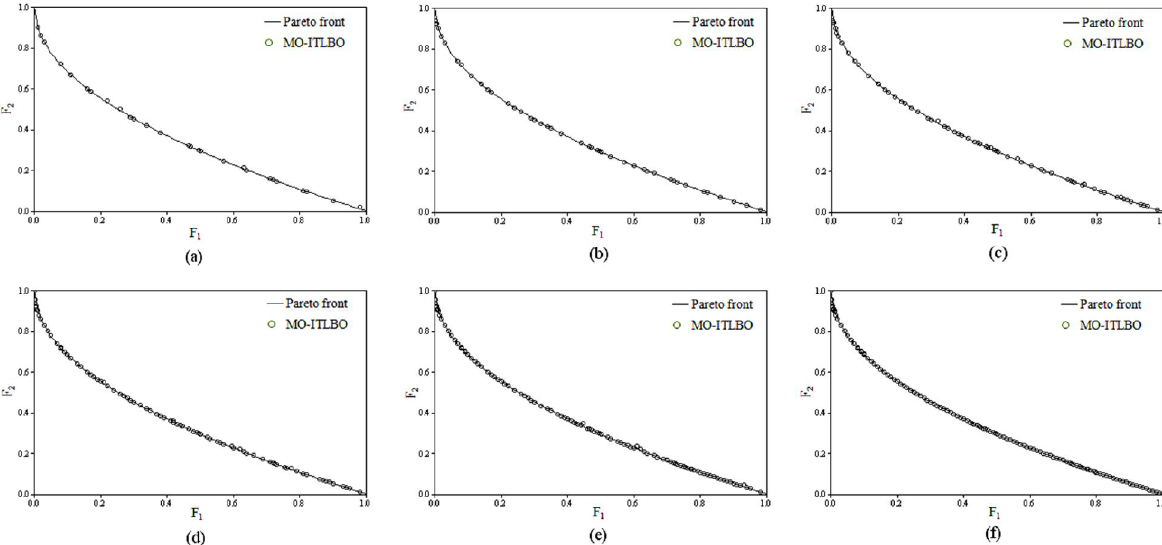
Fig. 5. Convergence of the MO-ITLBO algorithm for the unconstrained test function UF1 (a) 50000 FE